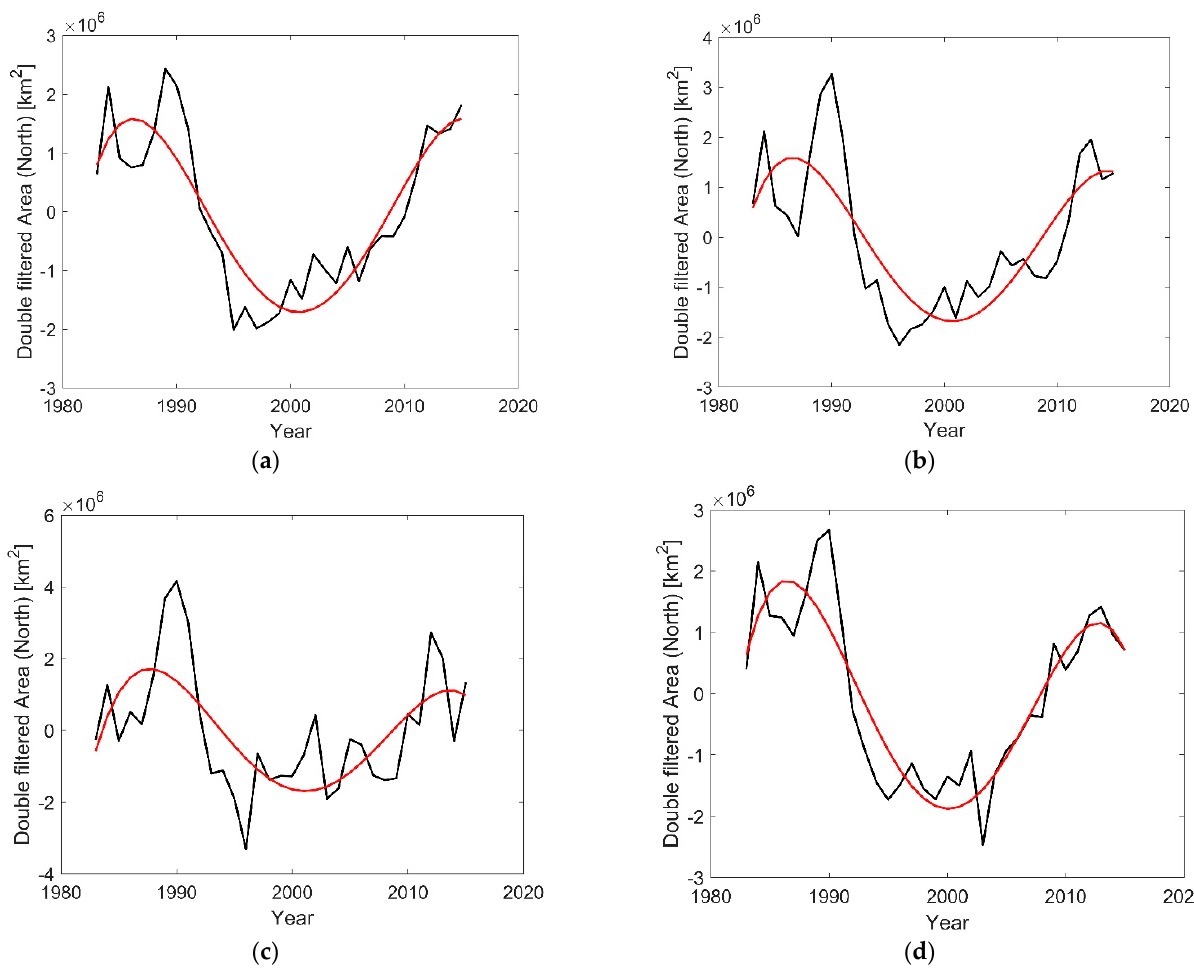
Figure 7. Northern hemisphere auroral outer boundary enclosed area A (km 2 ) time variation considering AB data with QC = 1 and 2 after filtering secular solar activity variation (black lines), and 4th-order polynomial fits (red lines), from the following filtered data series: AB data converted to A for 0 < Kp ≤ 2 ( a ), 2 < Kp ≤ 4 ( b ), 4 < Kp ≤ 6 ( c ), annual means of AB converted to A residuals from the linear regression with Kp ( d ). Note the different